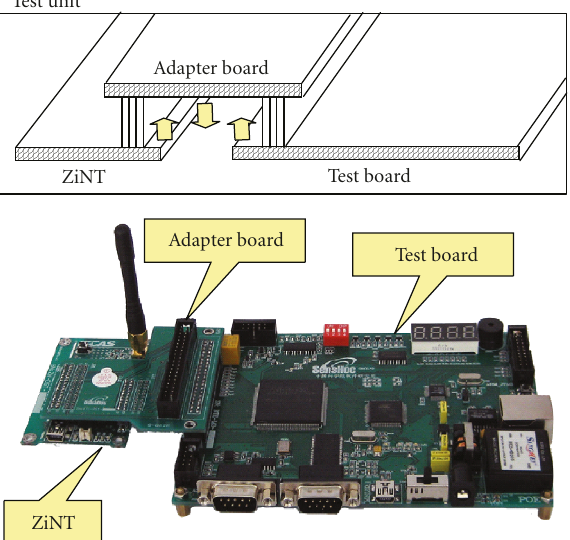
Figure 13: Mechanical structure of test